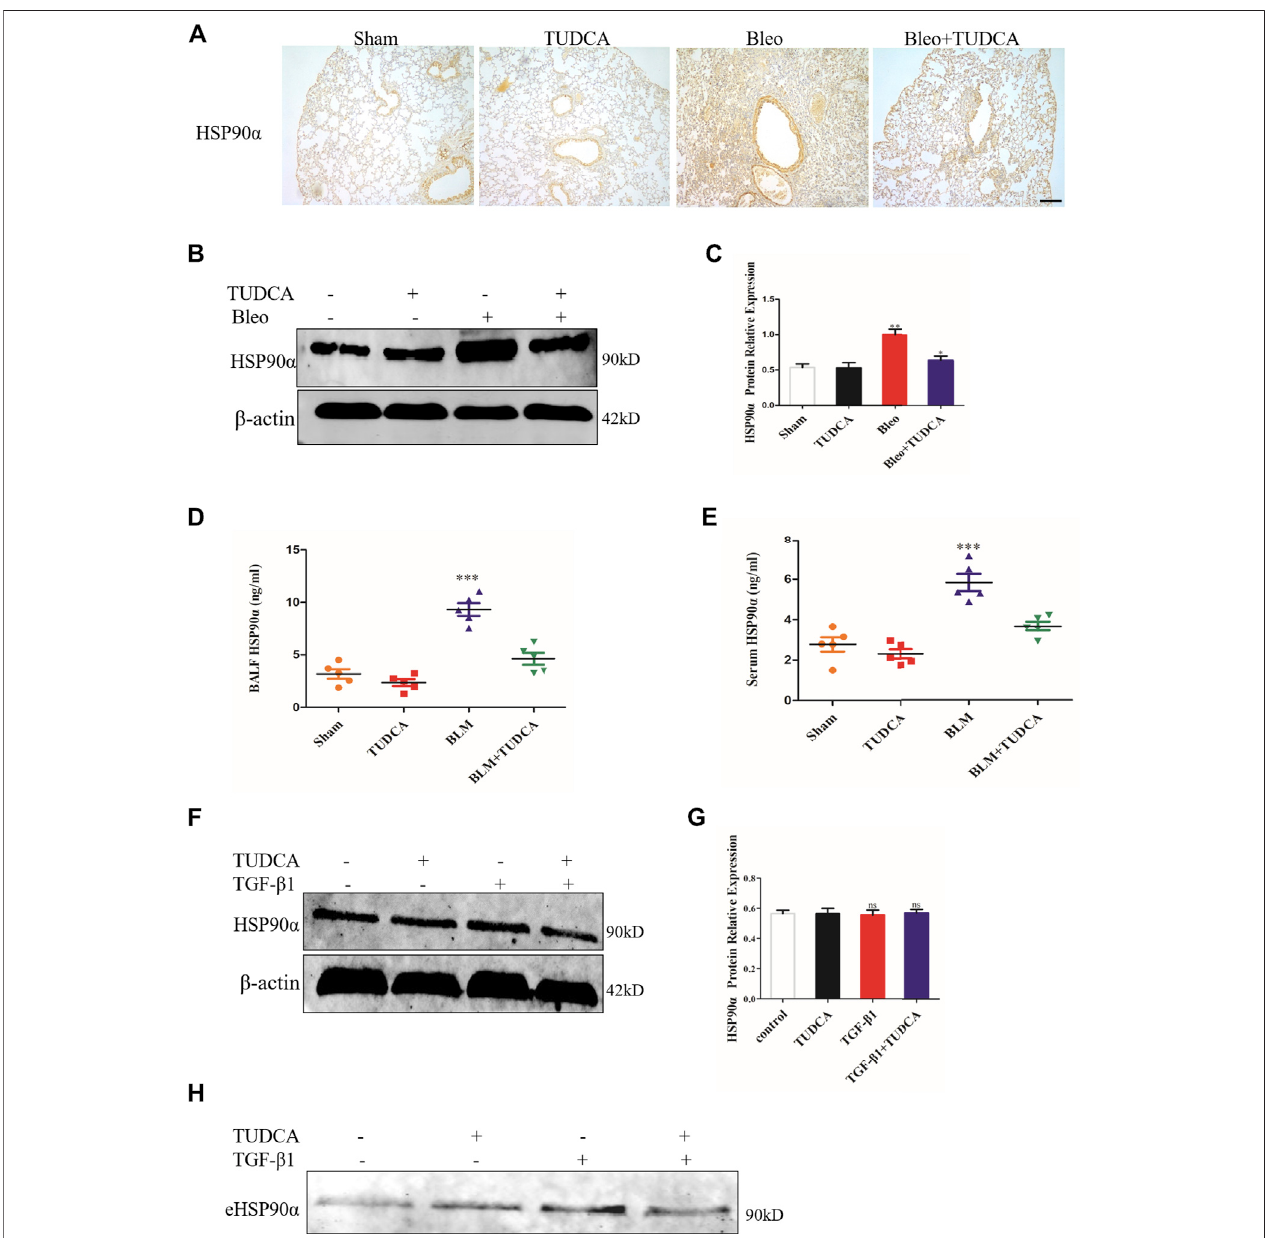
FIGURE9| TUDCAsigni fi cantlydecreasedtheextracellularHSP90 α secretion. (A) .RepresentativeimagesshowingHSP90 α stainingoflungtissuesofmice.Scale bar (cid:1) 100 μ m. (B,C) . The expression of HSP90 α was assessed by western blot. The content of HSP90 α in BALF (D) and in serum (E) samples in the mice were measuredbyELISA( n (cid:1) 5foreachgroup). (F,G) .WesternblotanalysisoftheexpressionofHSP90 α inIMR90cellspre-treatedwithTUDCA(100 μ M)followedbyTGF- β 1 stimuli. β -actin was used as an internal control. (H) . Secretion of HSP90 α in IMR90 cells pre-treated with TUDCA followed by TGF- β 1 treatment was detected by western blot. ns (cid:1) no signi fi cance, * p < 0.05, ** p < 0.01, *** p < 0.001.